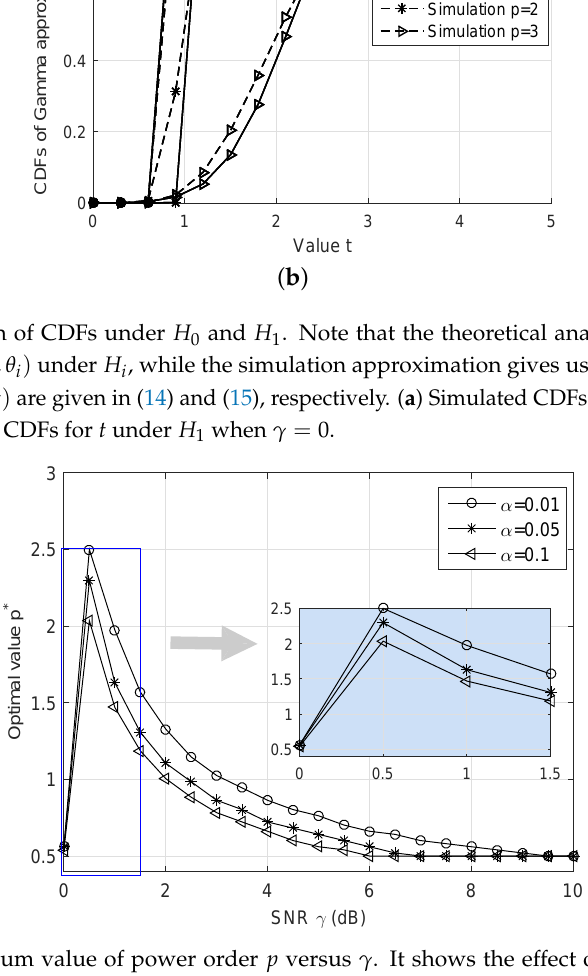
Figure 3. The optimum value of power order p versus γ . It shows the effect of γ on p ∗ at several different SNR levels, which comes from solving procedure of (26). We generated an SNR vector of 21 equally-spaced points between 0 and 10. The p ∗ -curve is aimed to choose the appropriate p value for the test